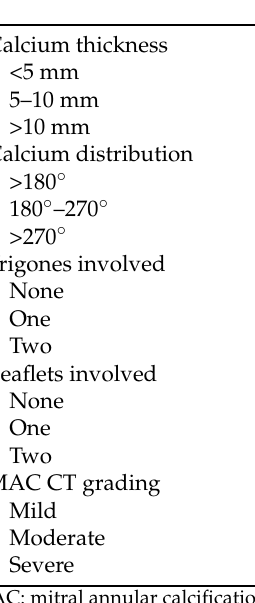
Table 2. Calcium distribution and MAC CT grading (n = 27).